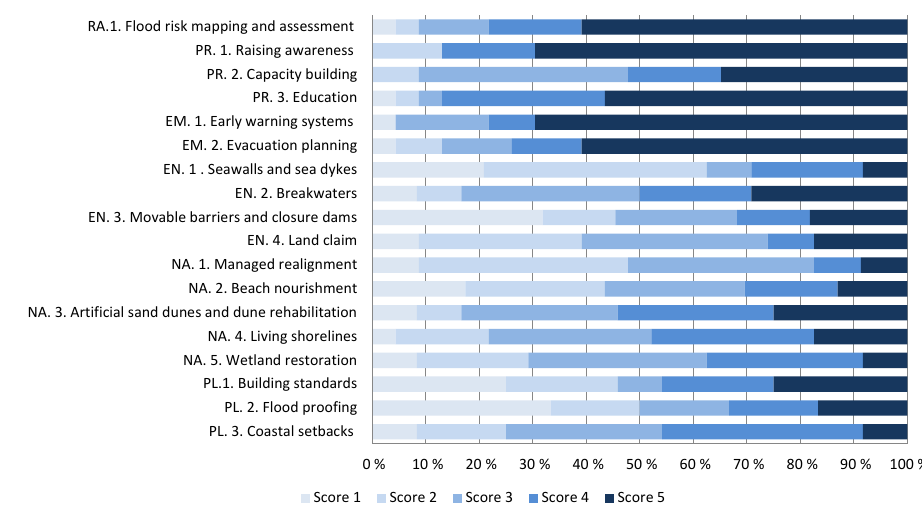
Figure 7. Scoring of the RRM according to the stakeholder panel ratings (1: the least preferred; 5: most